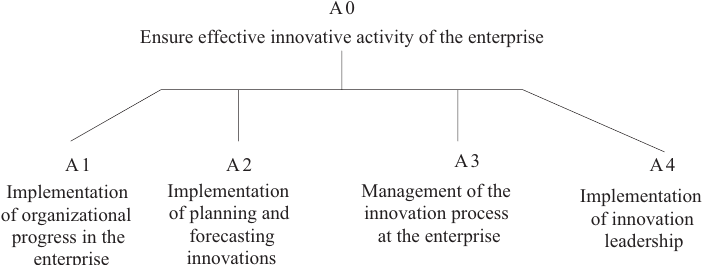
Figure 1. The main hierarchy of achieving A 0 for building a functional